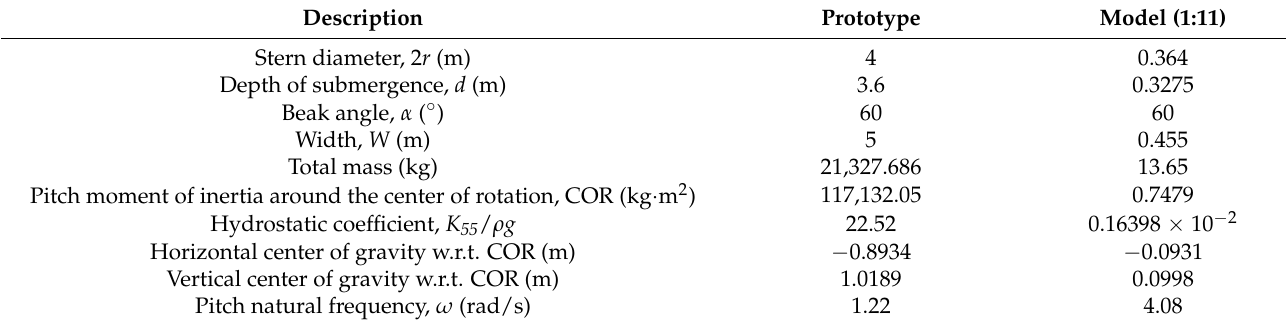
Figure 2. Schematic of multiple WEC rotors considered for analysis. Table 1. Principal particulars of prototype and model-scale isolated WEC